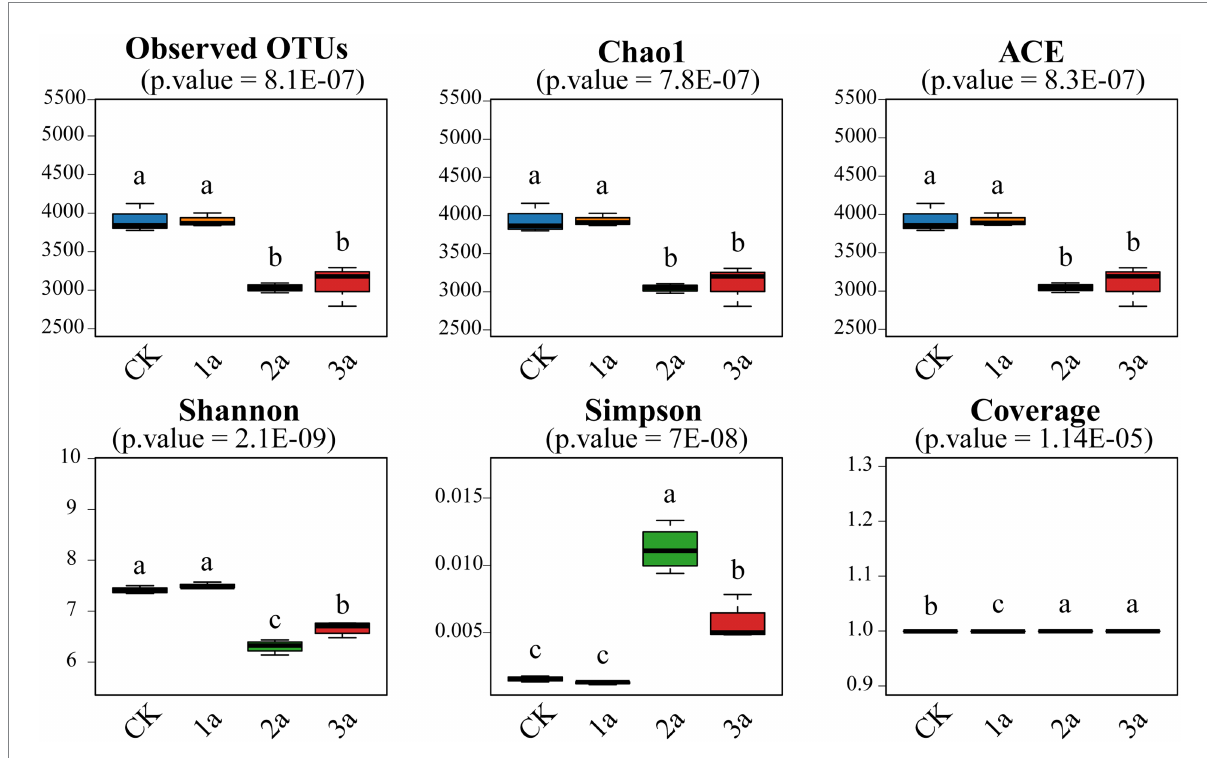
FIGURE 1 Bacterial alpha diversity of all the tested samples. CK, 1a, 2a, and 3a represent greenhouses consecutively planted for 0, 1, 2, and 3 years, respectively. Different letters indicate significant differences (Tukey’s HSD test, p < 0.05; n =